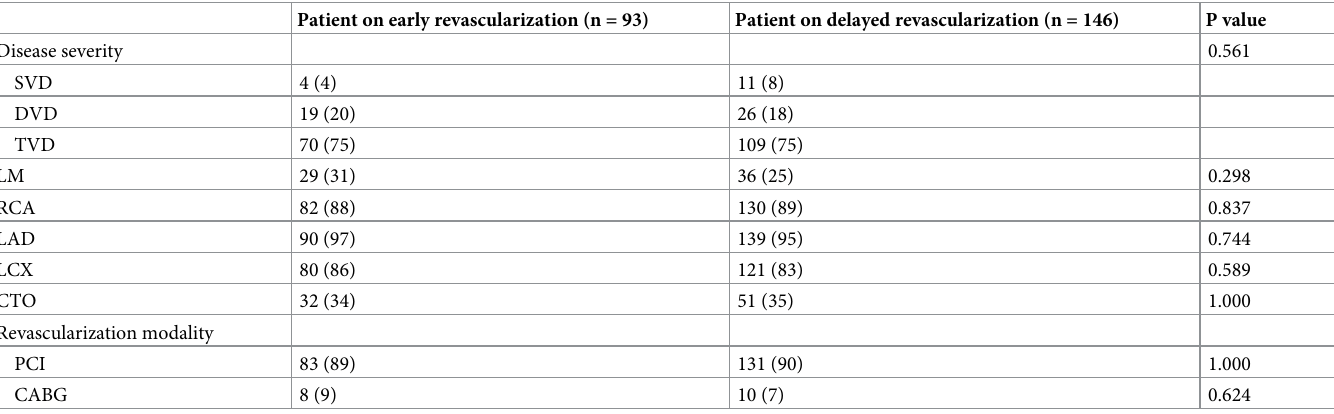
Table 2. Angiographic characteristics between patients with early and delayed revascularization.